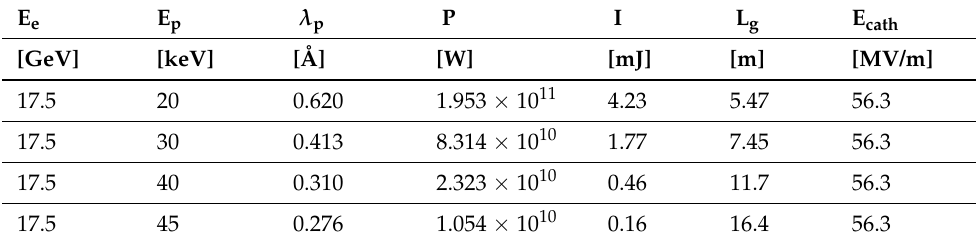
Table 2. Summary of SASE performance in the sub-ångström regime using low-emittance beams produced with 56.3 MV/m cathode accelerating gradient at a beam energy of 17.5 GeV. A undulator period of 4 cm is used. The notations follow those used in Table 1.